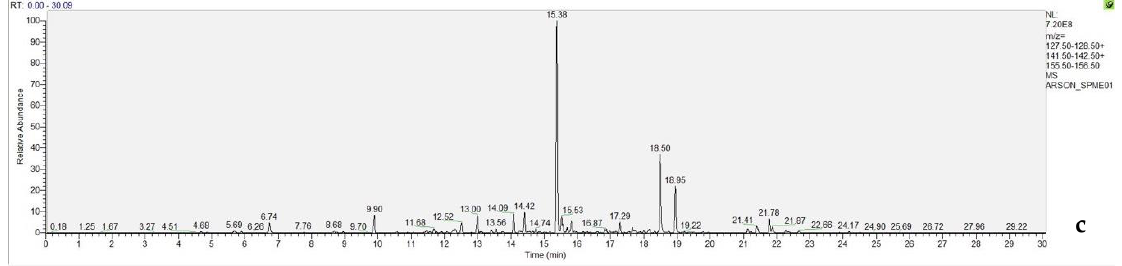
Figure 5. Extracted polynuclear aromatics profiles of ( a ) carpet #1, burned without ILs; ( b ) carpet #1 burned with gasoline; and ( c ) neat gasoline.